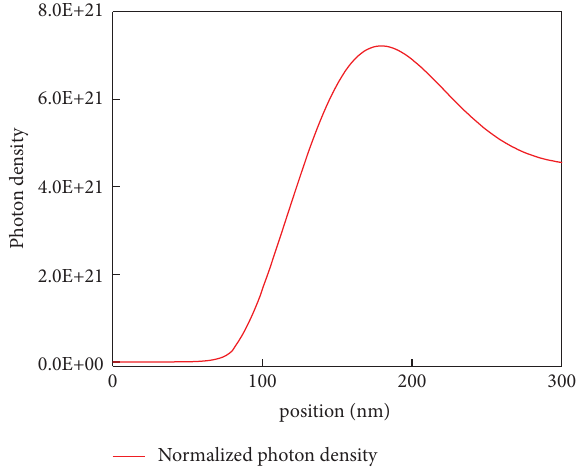
Figure 6: Normalized photon